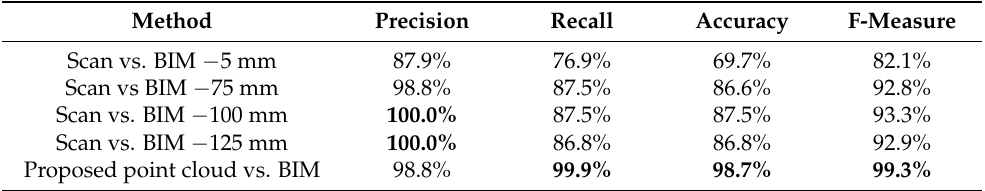
Table 1. Summary of the quality of point-cloud-to-model assignment using different methods. Method Precision Recall